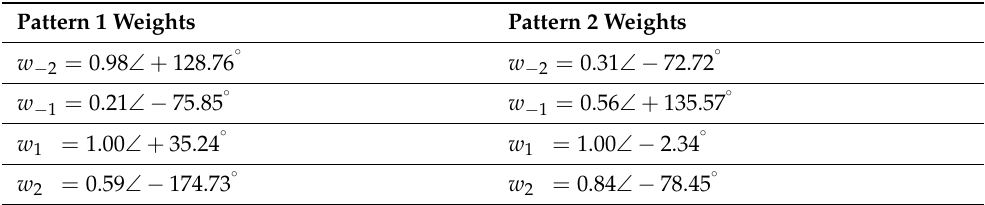
Table A1. Array weights of the conformal antenna on the wedge-shaped surface with θ b = 30 ◦ without coupling using (19).